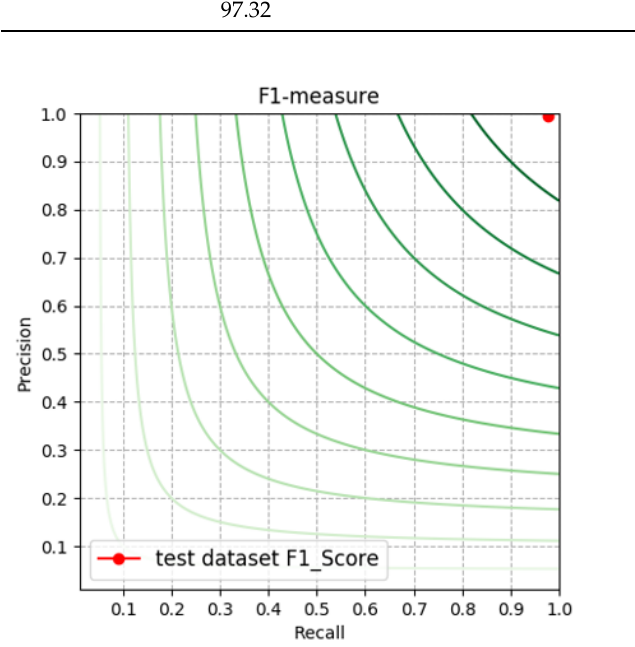
Figure 21. F1 score on the ROC plot.